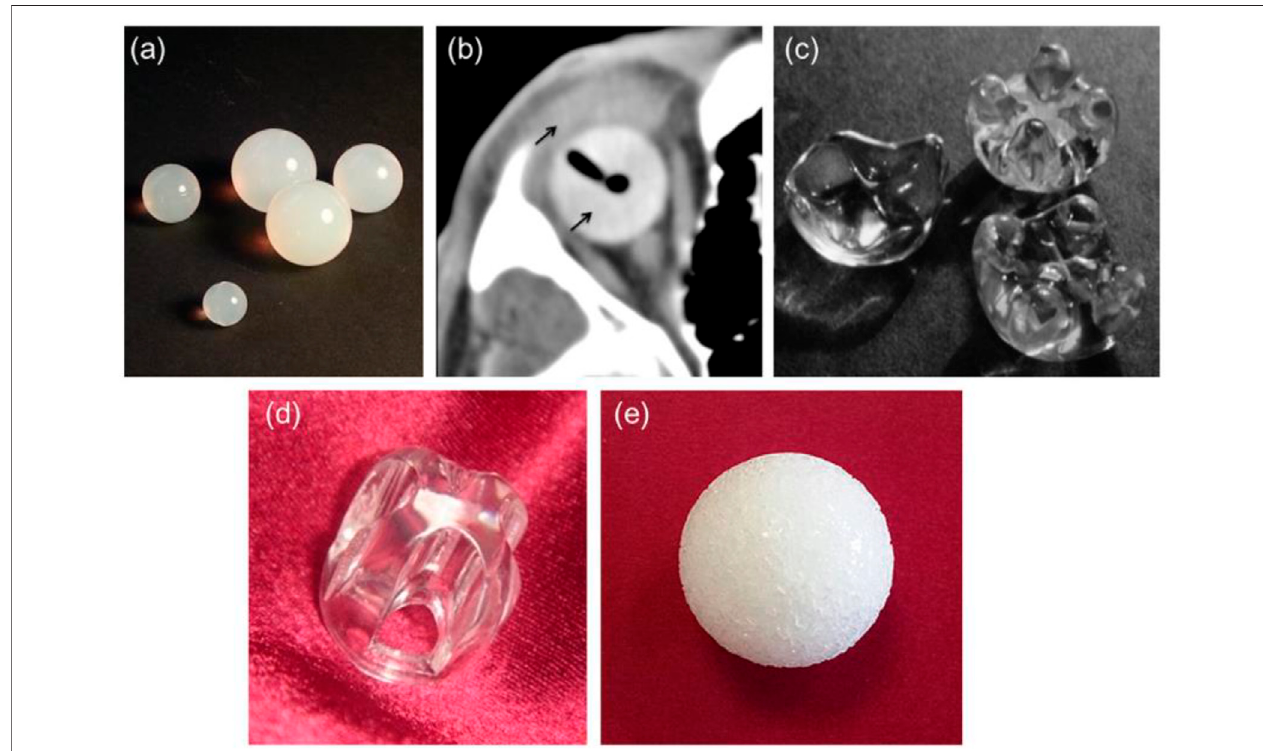
FIGURE 4 | (A) silicone spheres, (B) axial CT image of an acrylic spherical implant with ocular prosthesis implanted in vivo (thin black arrows), (C) acrylic orbital implants of the “ Allen family ” (Iowa implant and its conformer — upper right corner and left, respectively; universal implant — lower right; the size of the implants around 20 mm 20 mm), (D) Castroviejo implant, and (E) porous sphere. Reproduced with permission from (Adams et al.,